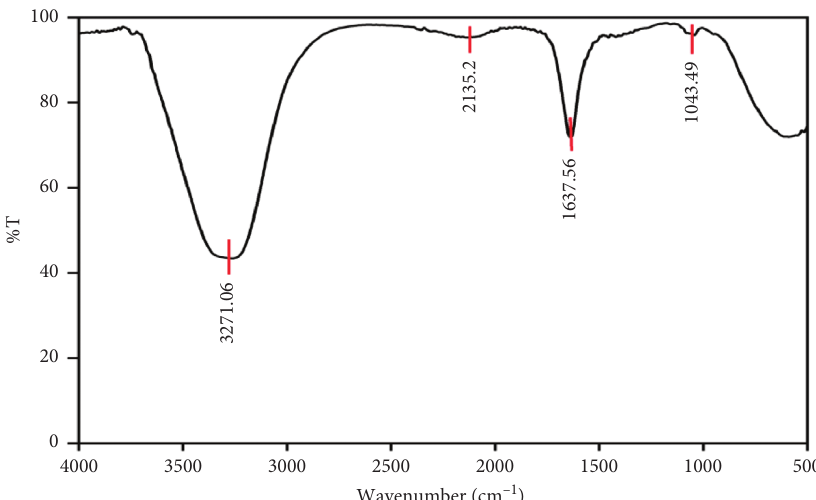
Figure 6: FT-IR spectrum of raw Centella asiatica (L.) Urban extract.